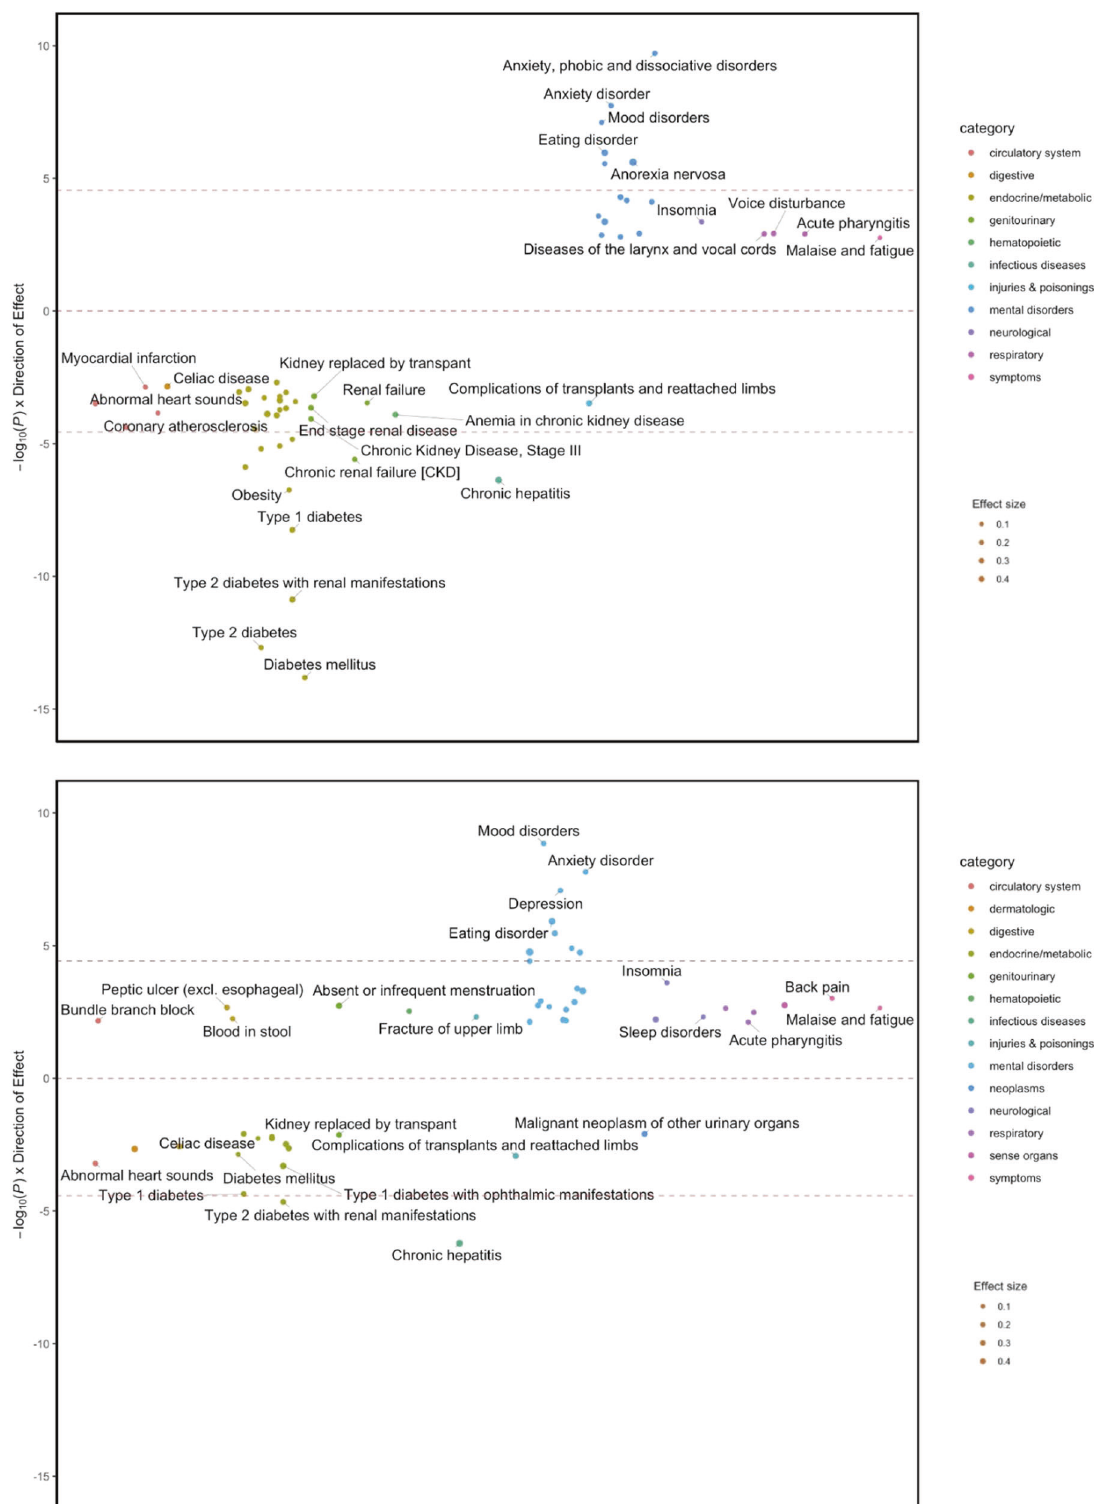
Fig. 2 PheWAS analysis showing shared genetic associations between risk for anorexia nervosa and other phenotypes in females. Signi fi cant positive correlations are shown between psychiatric conditions and signi fi cantly negative correlations are shown with metabolic phenotypes (upper panel). After controlling for PRS BMI , most of the metabolic phenotypes were attenuated (lower panel), while the psychiatric phenotypes remained relatively